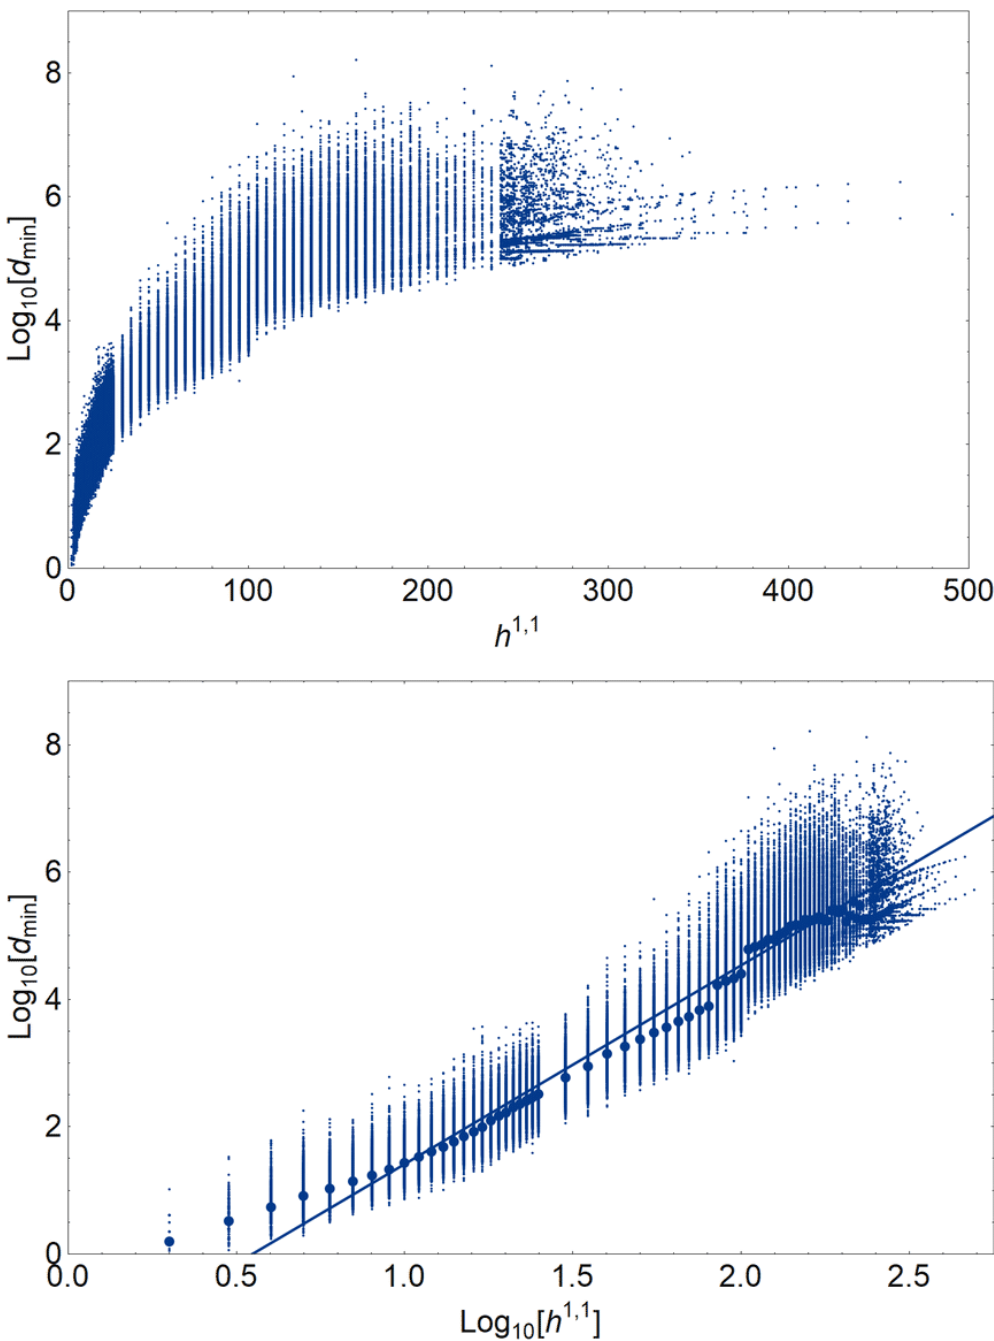
Figure 4. log (cid:0) 1 : 7 + 3 : 1 log